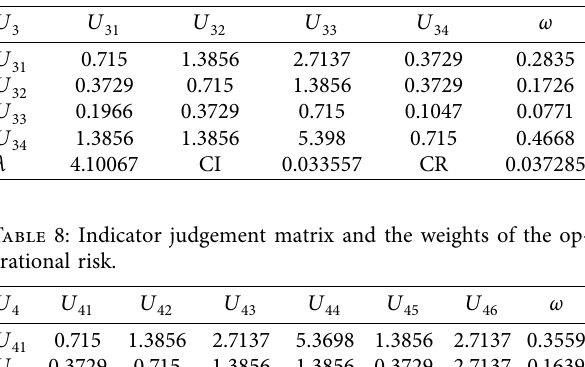
Table 7: Indicator judgement matrix and the weights of the construction completion risk.